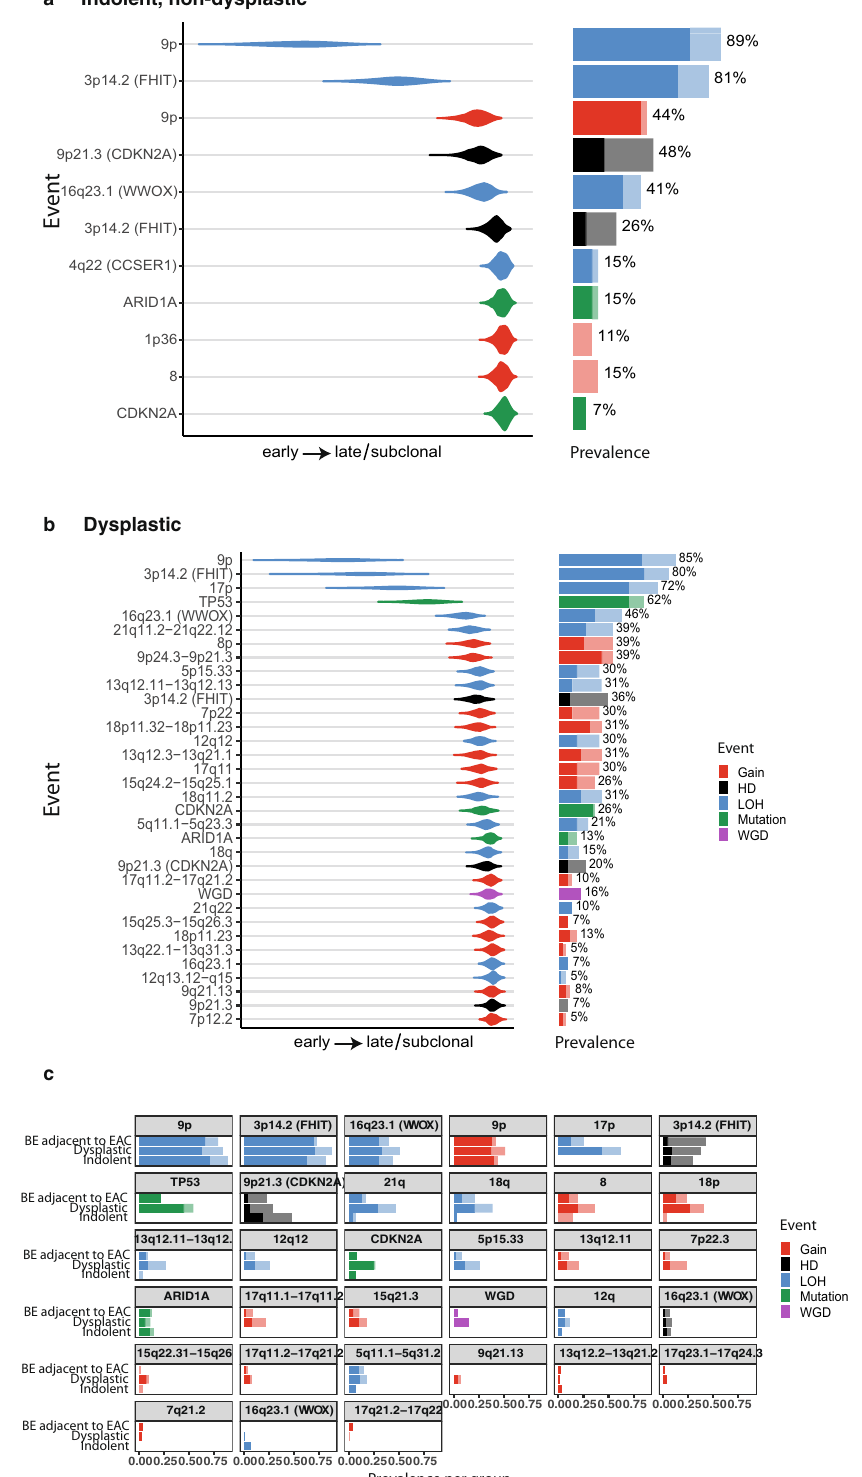
Fig. 3 Timing of genomic events. The timing of speci fi c genomic events for indolent ( a ) and dysplastic ( b ) samples, showing the relative ordering of copy number events, driver mutations and WGD. c Prevalence of copy number events, driver mutations and WGD per group (indolent, progressed, BE adjacent to the tumour). The events are ordered in the relative order of occurrence determined by the Plackett-Luce model. The lighter colours indicate sub-clonal events. LOH loss of heterozygosity, HD homozygous deletion, WGD whole-genome